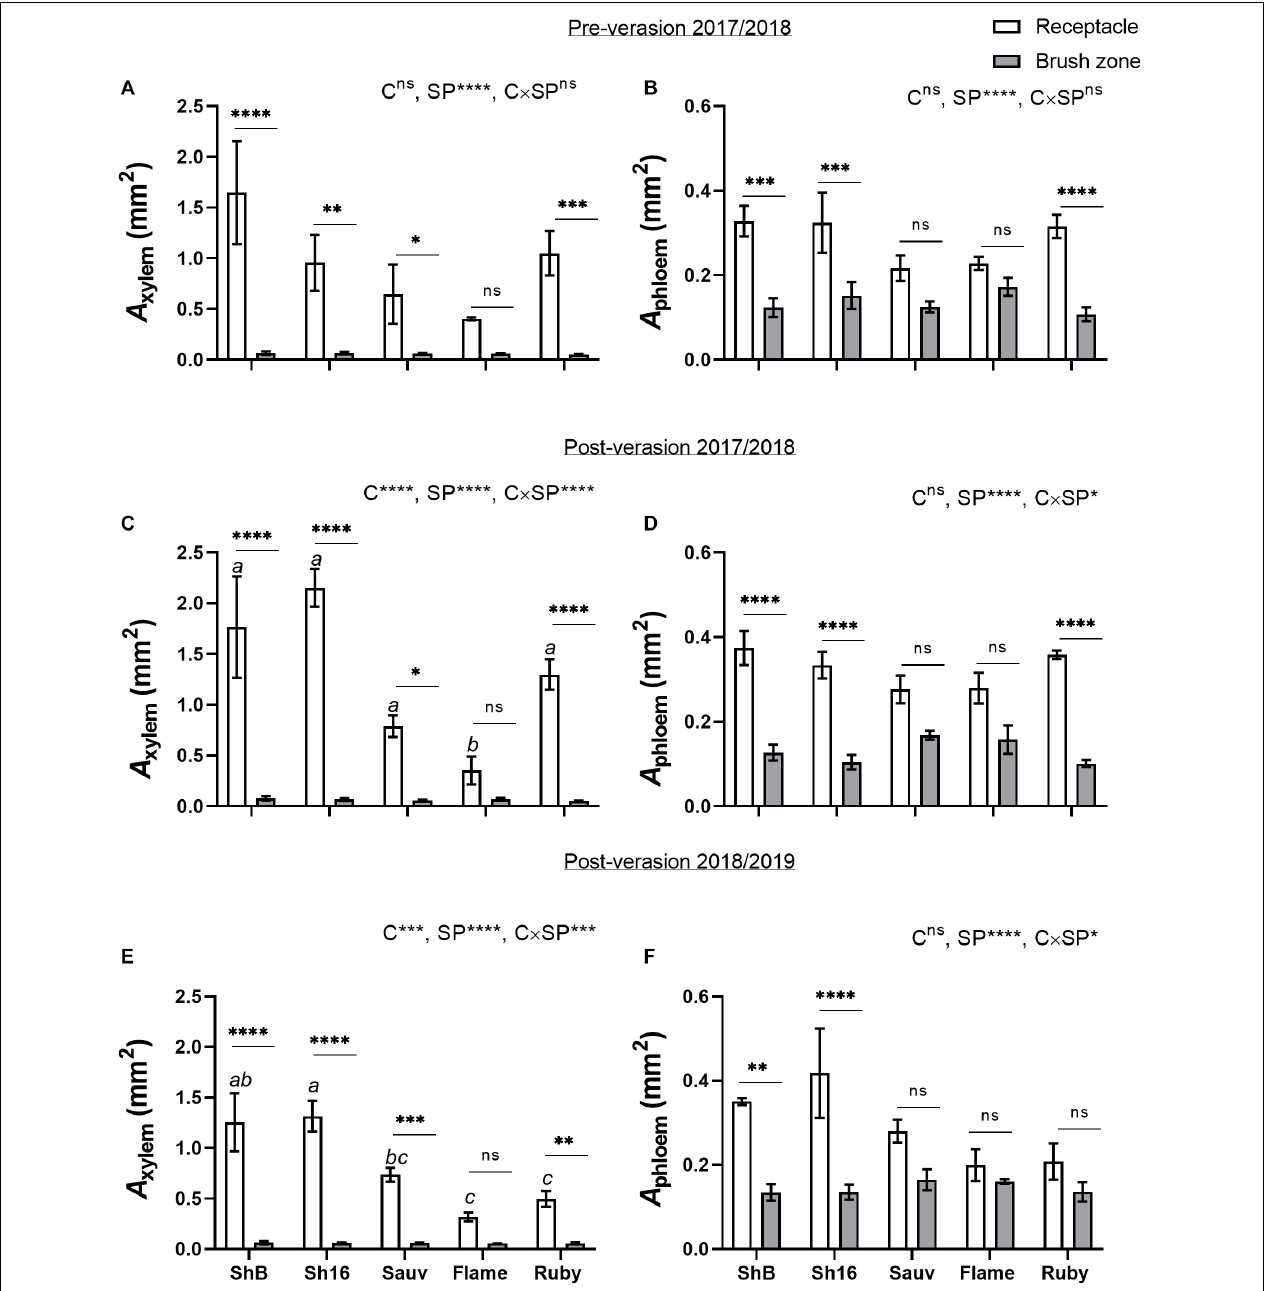
FIGURE 11 | Cross-sectional areas of xylem ( A xylem ) (A,C,E) and phloem ( A phloem ) (B,D,F) in receptacles and brush zones of Shiraz BVRC12 (ShB), Shiraz 1654 (Sh16), Sauvignon Blanc (Sauv), Flame Seedless (Flame), and Ruby Seedless (Ruby) before and after veraison in the 2017/2018 season and after veraison in the 2018/2019 season (data of brush zone 2 was used for Post-veraison 2018/2019). Data are presented as mean ± s.e.m. ( n = 3 or 4). The ANOVA results are given for cultivar (C), section position (SP) and cultivar × section positon (C × SP) interaction. Levels of significance are * P < 0.05, ** P < 0.01, *** P < 0.001, **** P < 0.0001 and ns , not significant. Where different lower-case letters are shown, it indicates differences in A xylem between cultivars and there is no difference in